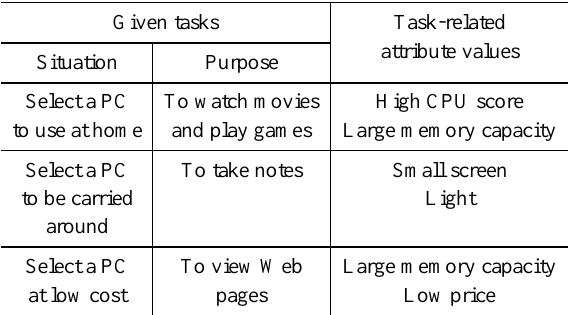
Table 1. Three tasks and task-related attribute values Given